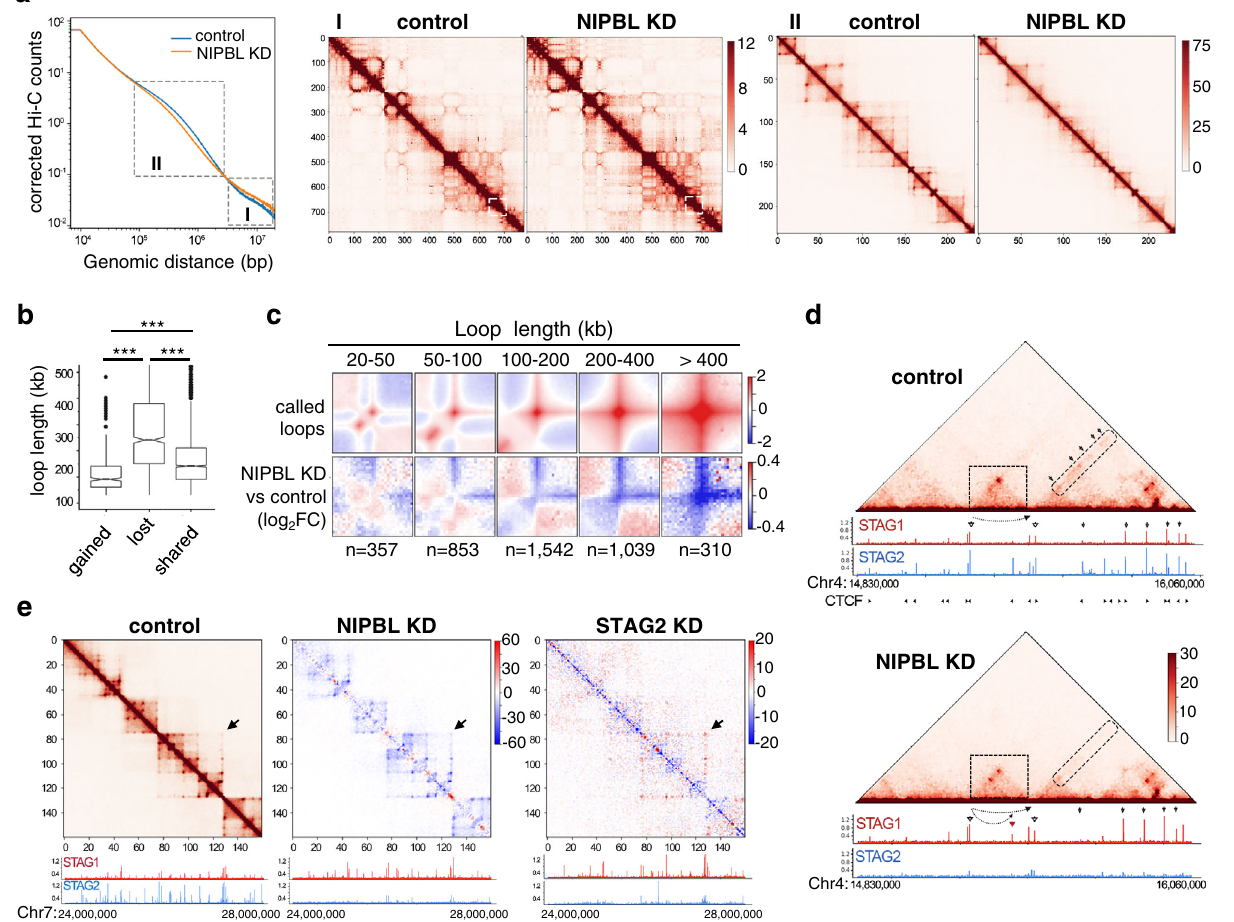
Fig.5|NIPBLisrequiredforloopextrusion.a Contactprobabilityasafunctionof genome distance in control and NIPBL KD cells (left) and normalized